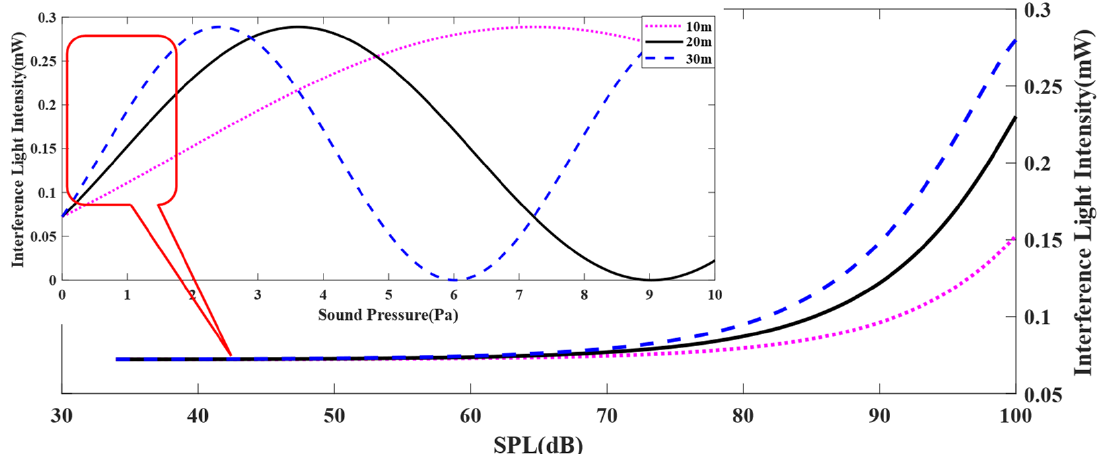
Figure 4. The influence of optic fiber acoustic pick-up length. With the delay fiber is 2 km and optic fiber acoustic pick-up is 20 m, the influence of sound frequency and SPL on the interference light intensity is shown in Figure 5. When the sound frequency is 5000 Hz and the SPL is 50 − 100 dB, the relationship between interference light intensity and sound pressure will remain near linearity and there is no interference crest point in the sound-pressure range, which means there is no blind hearing problem. These results show that the designed system can be used as a sensor for sound detection with frequency 5000 Hz and SPL 50 − 100